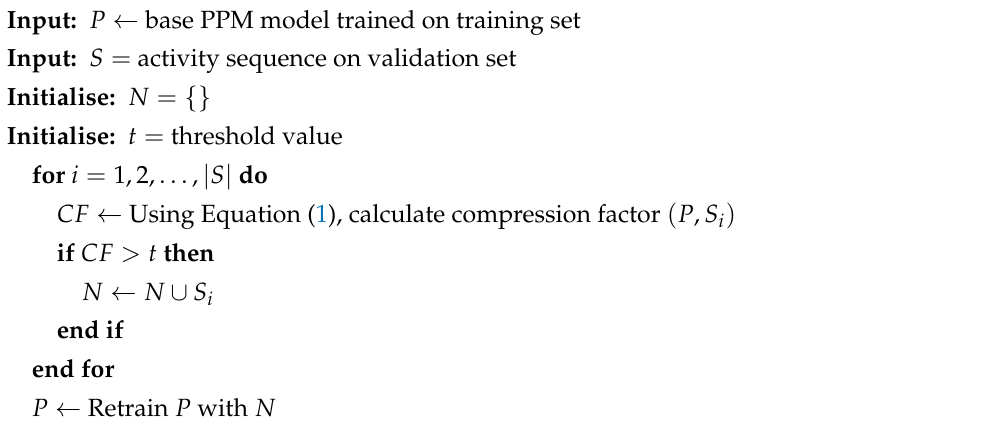
Algorithm 1 Novelty Detection based on Prediction by Partial Matching